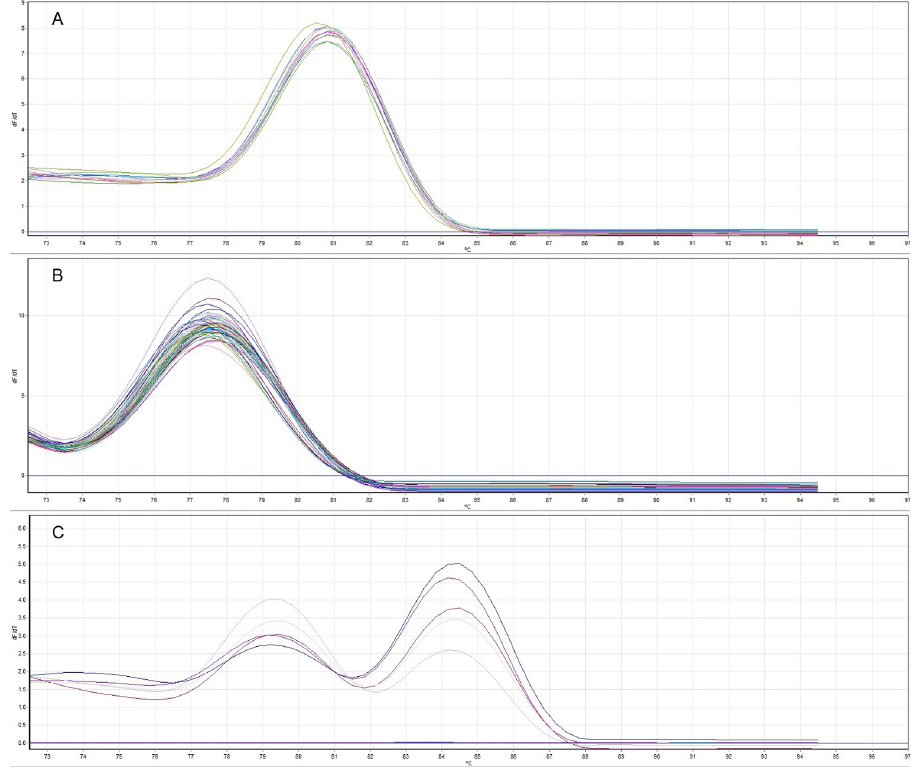
Fig 1. A. Melt curve analysis of 12 Fusarium oxysporum f. sp. cubense Lineage VI target DNA samples with melting points of 80.2–80.5˚C. B: Melt curve analysis of 50 TR4 target DNA samples with melting points of 77.2–77.8˚C. C: Melt curve analysis of five STR4 DNA samples with melting points of 79.2–79.5˚ and 84.2–84.5˚C. Target DNA samples varied from ~20–0.02 ng/ μ l.